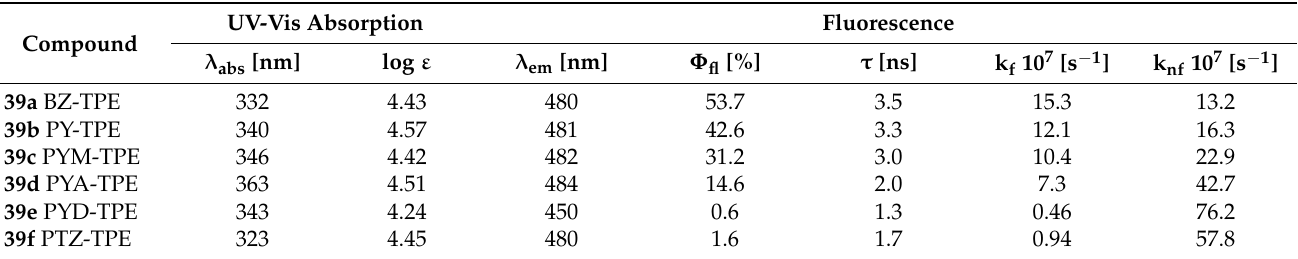
Table 5. Photophysical data for the as-prepared luminogens. Compound